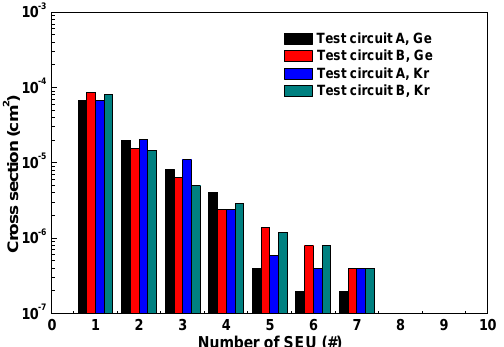
Figure 9. Measured results with different ion energies and species. The incident heavy ions have the similar LET values. However, they have different incident range and energies at the silicon